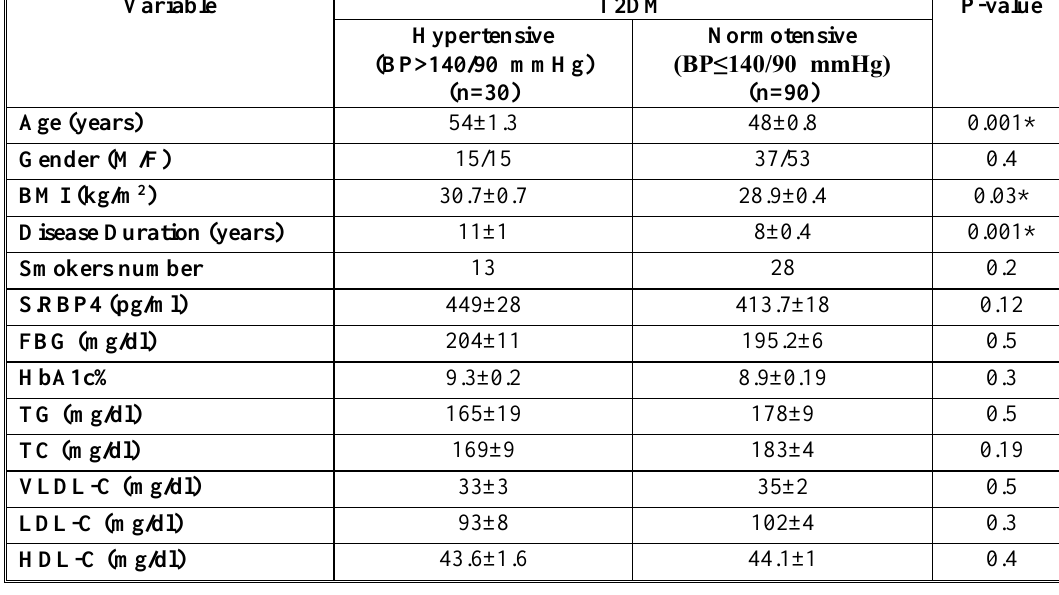
Table- 2. Characteristics of hypertensive and normotensive T2DM